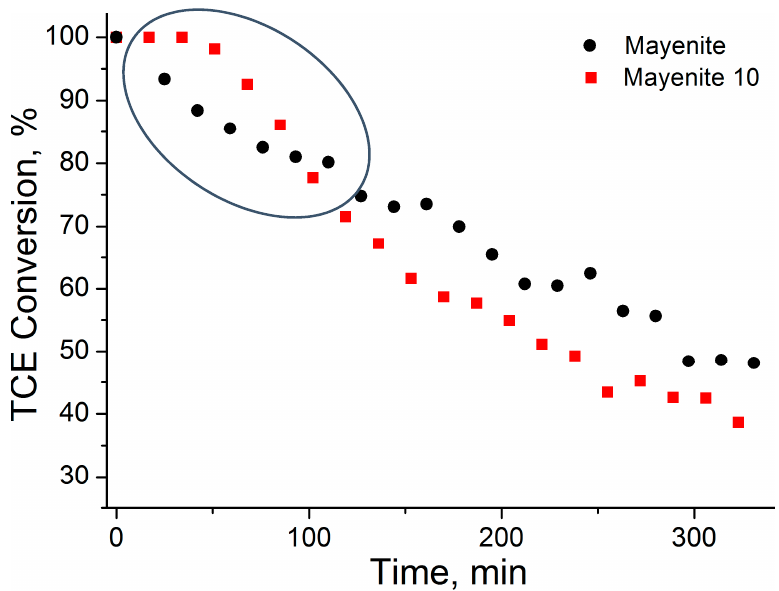
Figure 4. Stability curves for mayenite (black circles) and mayenite 10 (red squares) catalysts (catalyst = 0.7 g, [TCE] = 1000 ppm, water vapour = 1.7%, flux = 400 mL/min, GHSV = 12,000 h − 1 , T = 500 °C).